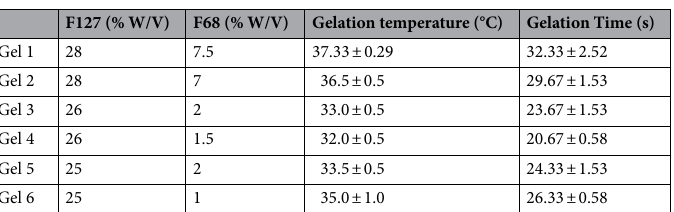
Table 2. Gelation temperature and gelation time of the different fomulations by adjusting concentrations of F127 and F68 in GenNLC-Dex-Mox delivery system (mean ± SD) (n = 3).